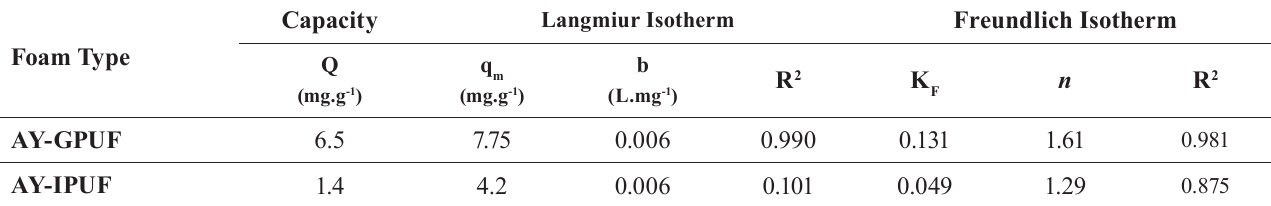
TABLE I - I sotherm parameters for the adsorption of CAF onto AY-GPUF and AY-IPUF sorbents at 25 o C